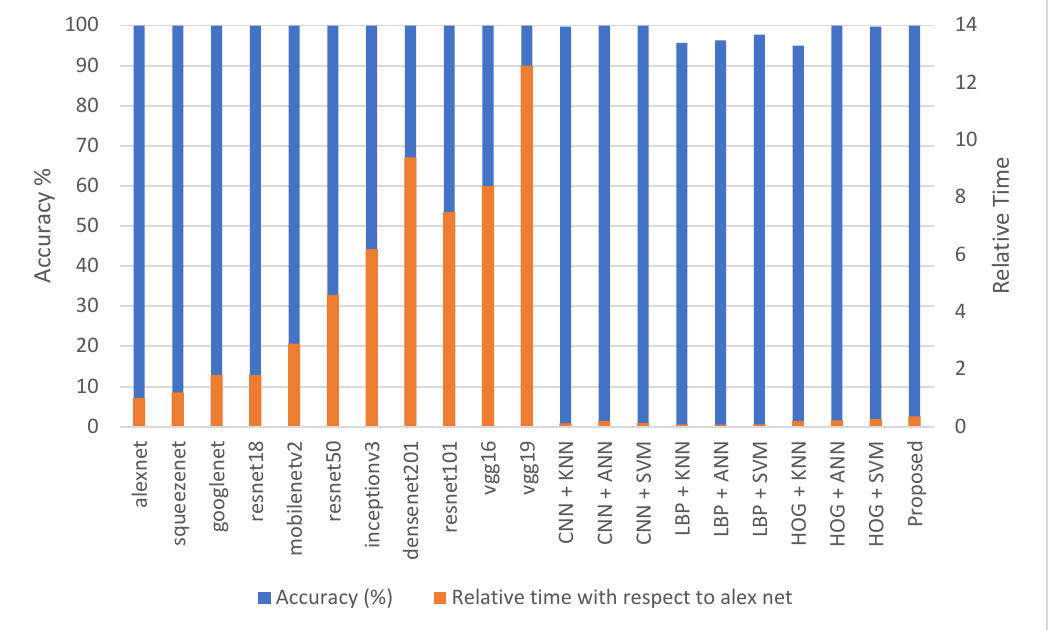
Figure 10. Performance comparison under the conditions of the sufficient availability of training data (largest training dataset).